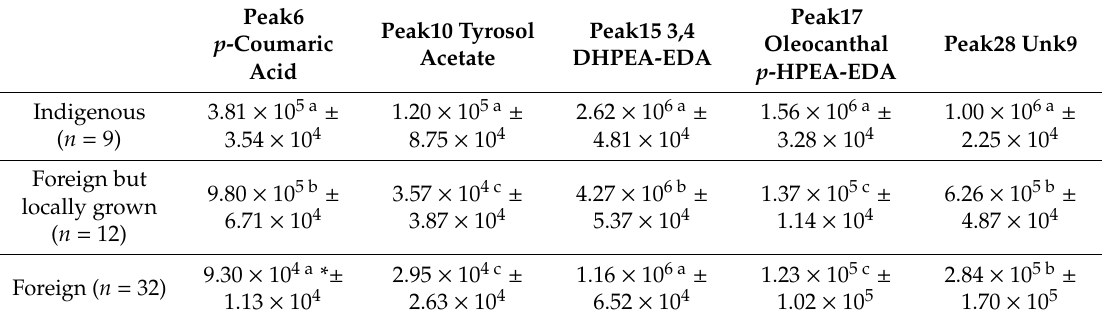
Superscript letters in the same column represent statistically distinct homogeneous subsets as determined by an ANOVA and post hoc Tukey analysis at a 5% confidence level, same letters followed by an * indicate homogeneous subsets at a 10% confidence